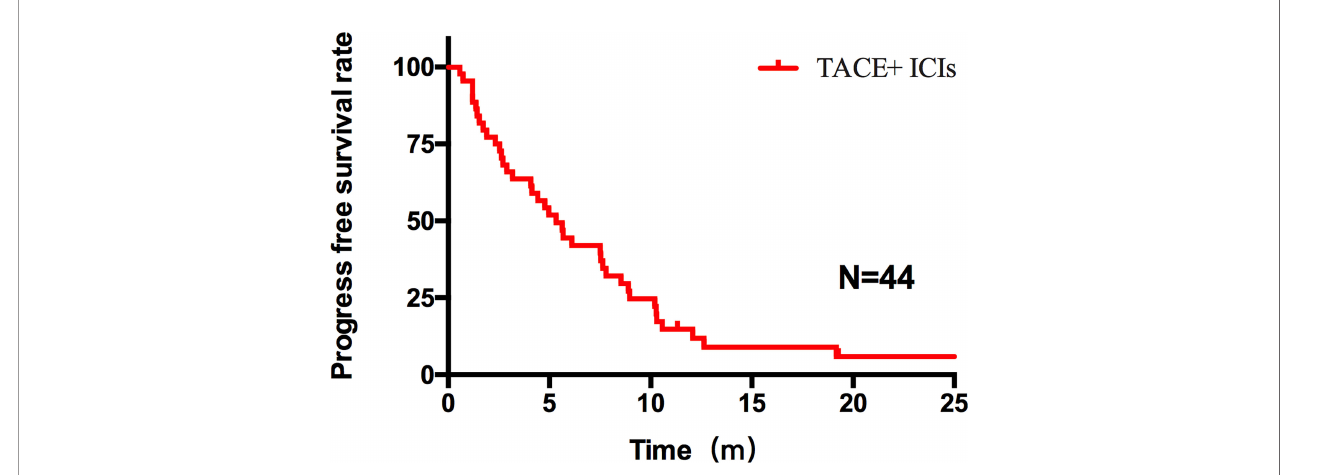
FIGURE 1 | PFS of all patients after TACE – ICIs combined therapy. Patients after TACE-ICIs combined therapy achieved a median progression-free survival of 5.33